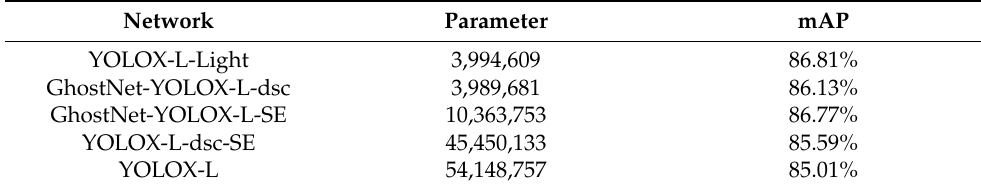
Table 8. The results of each lightweight improvement method.